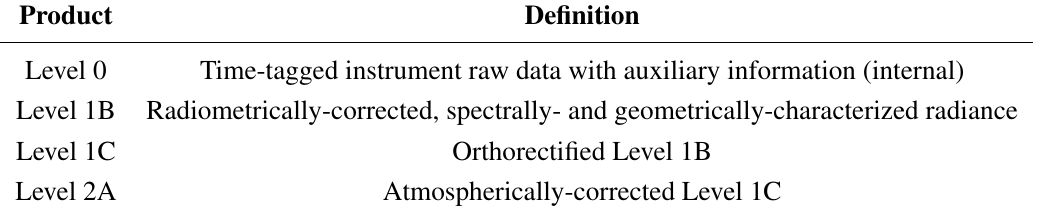
Table 3. Definition of EnMAP data